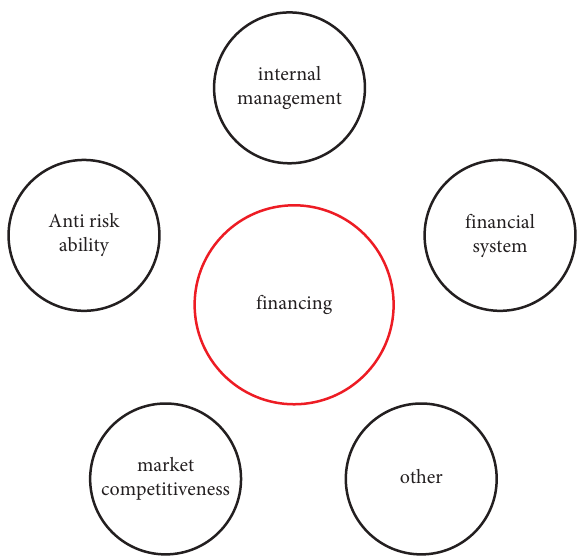
Figure 2: Financing and influencing factors.